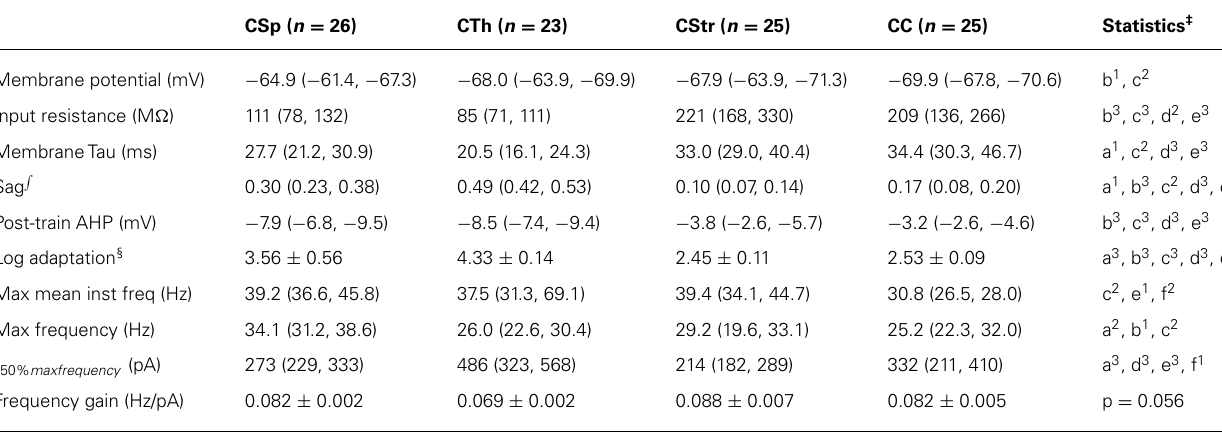
Table 2 | Electrophysiological properties of M1 layer 5 projection neurons (26 ◦ C).